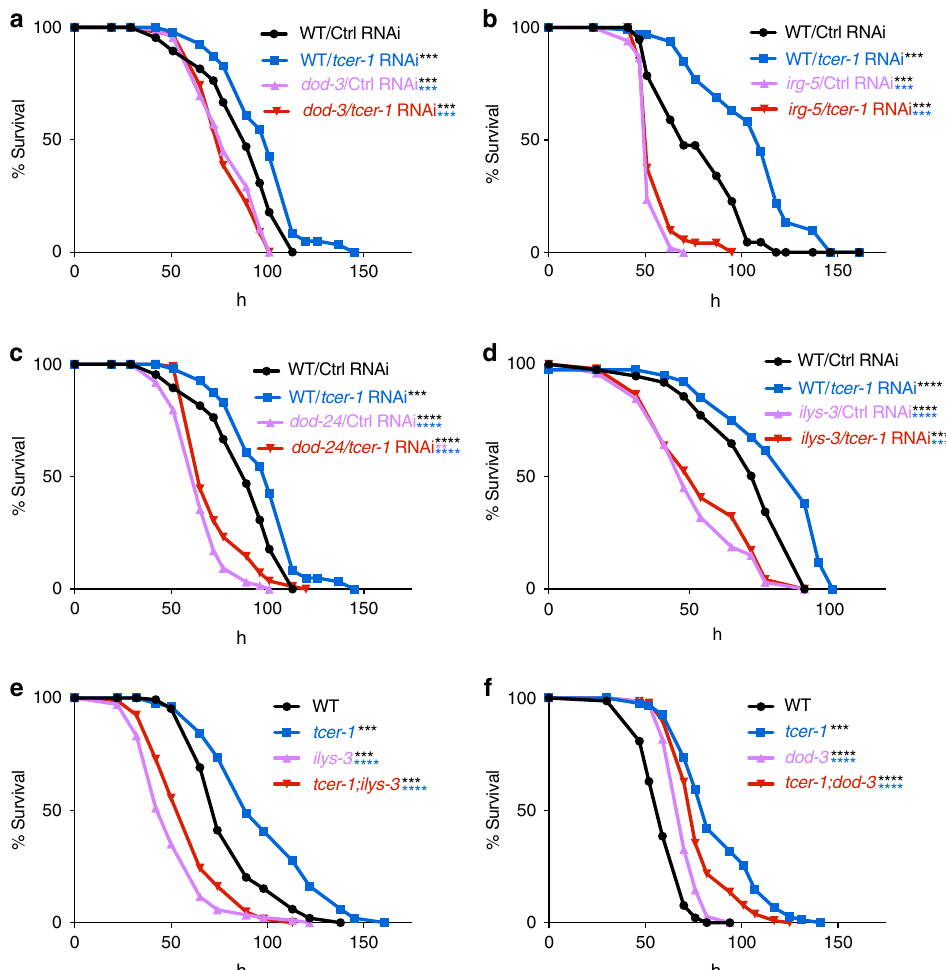
Fig. 7 TCER-1-repressed genes are essential for resistance against PA14. Survival of wild-type L4 animals grown from egg stage on empty control vector (black, WT/Ctrl) or tcer-1 RNAi bacteria (blue, WT/ tcer-1 ) and then transferred to PA14 plates compared to the survival of a dod-3 , b irg-5 , c dod-24 or d ilys-3 mutants grown on empty control vector (pink curves) or tcer-1 RNAi bacteria (red). a WT/Ctrl ( m = 87.63 ± 2.2), WT/ tcer-1 ( m = 99.27 ± 2.1), dod-3 / Ctrl ( m = 79.95 ± 1.5), dod-3 / tcer-1 ( m = 78.8 ± 1.4). b WT/Ctrl ( m = 77.67 ± 3.0), WT/ tcer-1 ( m = 104.62 ± 2.7), irg-5 /Ctrl ( m = 53.07 ± 0.7), irg-5/tcer-1 ( m = 56.69 ± 1.2). c WT/Ctrl ( m = 87.63 ± 2.2), WT/ tcer-1 ( m = 99.27 ± 2.1), dod-24 /Ctrl ( m = 66.18 ± 1.4), dod-24/tcer-1 ( m = 74.20 ± 1.5). d WT/Ctrl